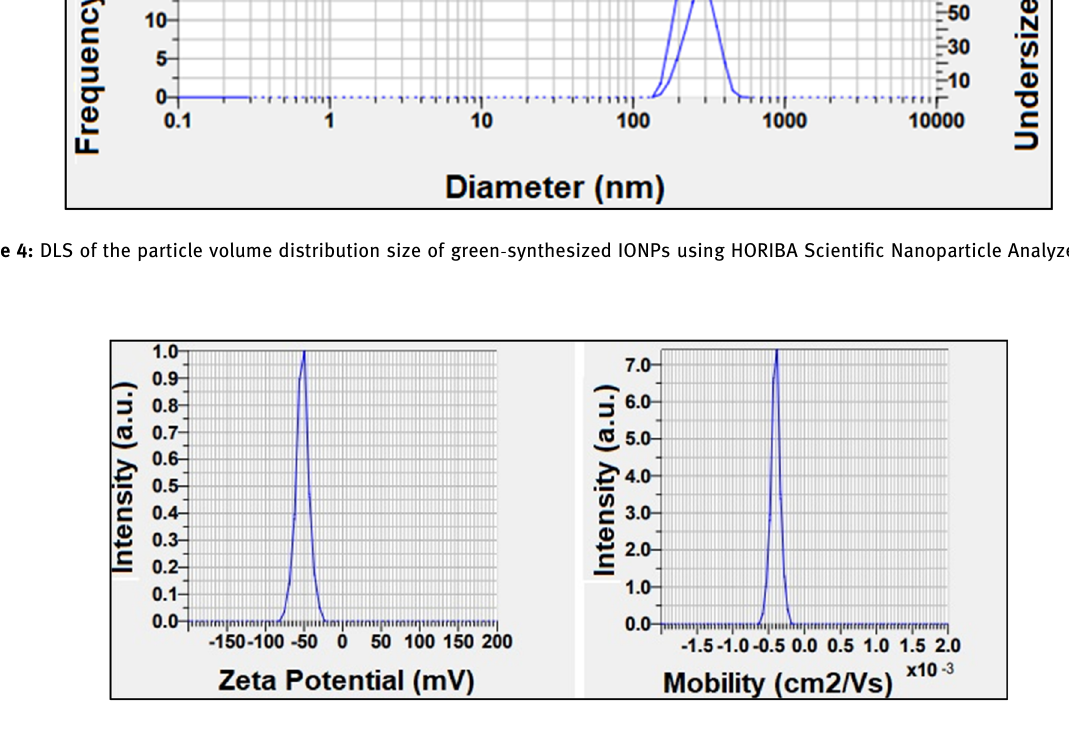
Figure 5: ZP analysis ( ζ = − 51.8 mV ) of green - synthesized